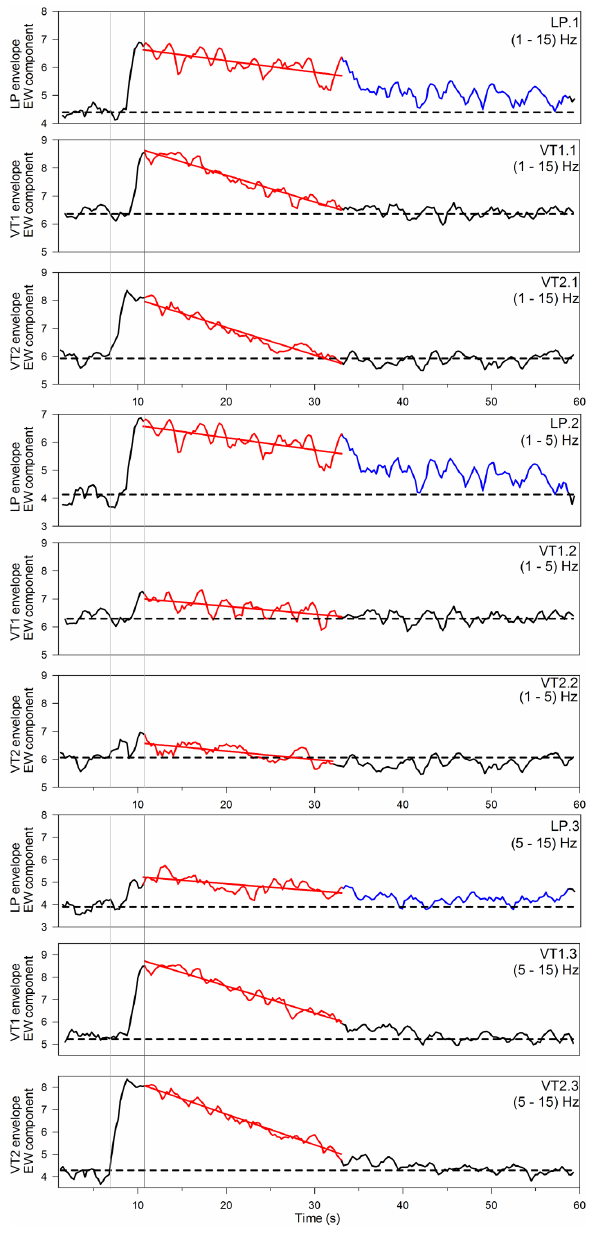
Figure 7. Comparison of the natural logarithms of the envelopes of the EW component for the three events. Three frequency bands are shown, as indicated in the upper-right corner of each panels. The black dashed lines indicate the logarithm of the mean noise enve- lope in each frequency band, estimated over a time interval of 10 minutes. The vertical light gray lines mark the P-onset, while the dark gray lines mark the coda theoretical starting time. The red lines evidenced the coda envelopes used for the comparison, with their linear fits, while blue lines highlight the actual LP